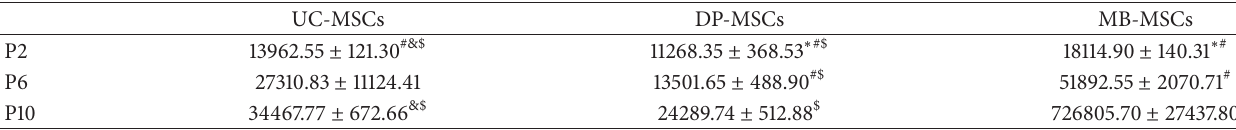
Table 3: Senescence of UC-MSCs, DP-MSCs, and MB-MSCs.